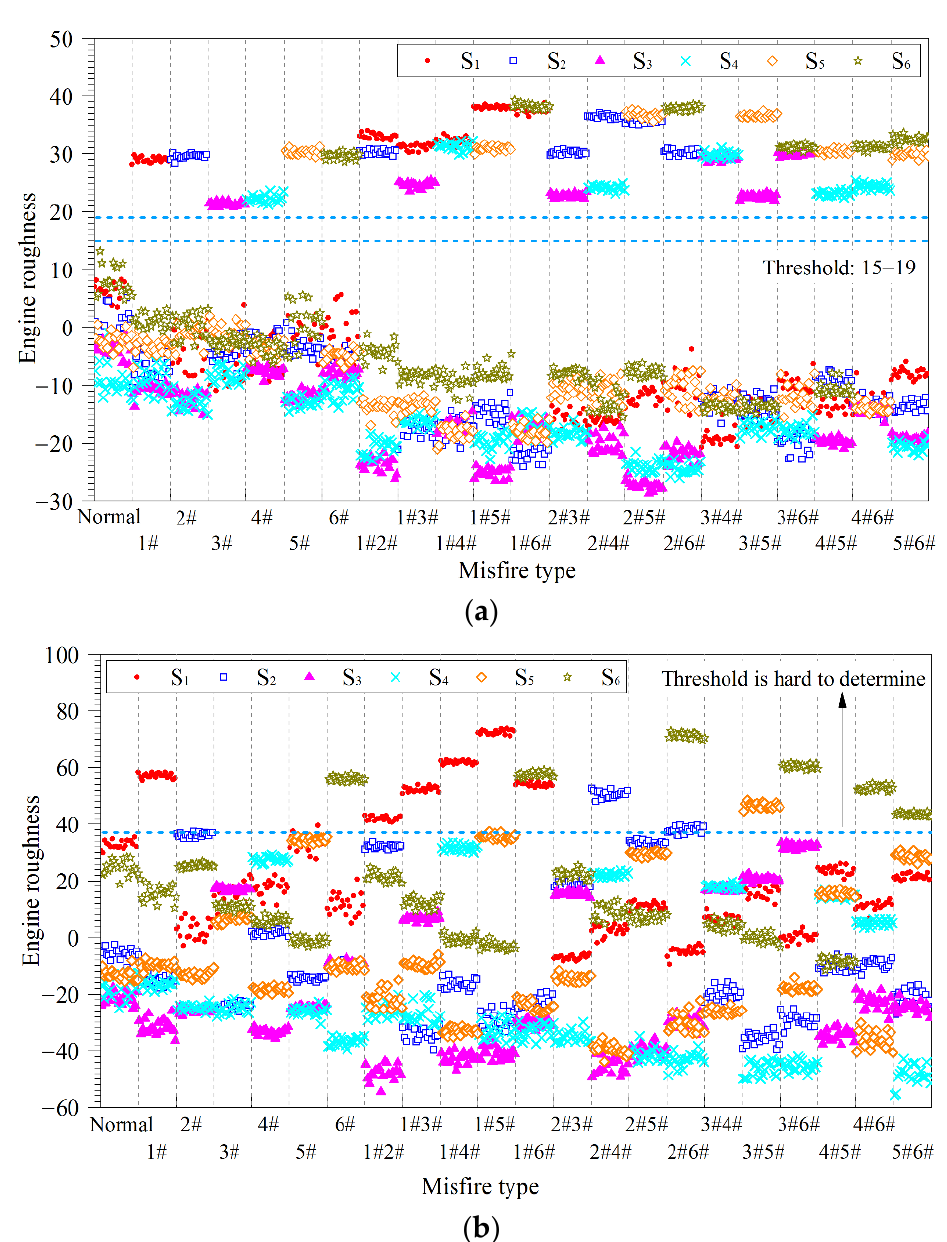
Figure 5. Engine roughness under normal and misfire conditions. ( a ) Under 1200 r/min and no-load condition. ( b ) Under 1900 r/min and no-load condition.